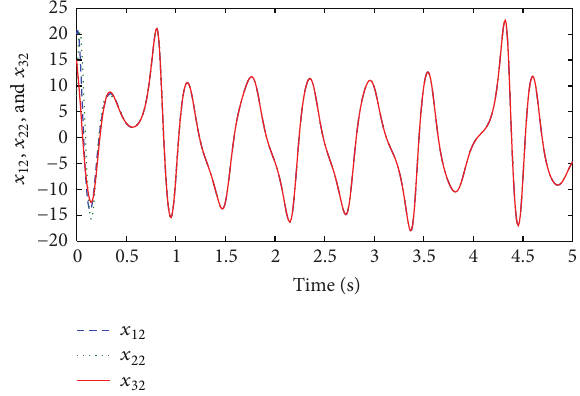
Figure 7: The state trajectories 𝑥 12 , 𝑥 22 , and 𝑥 32 of the chaotic sys- tems with time 𝑡 .